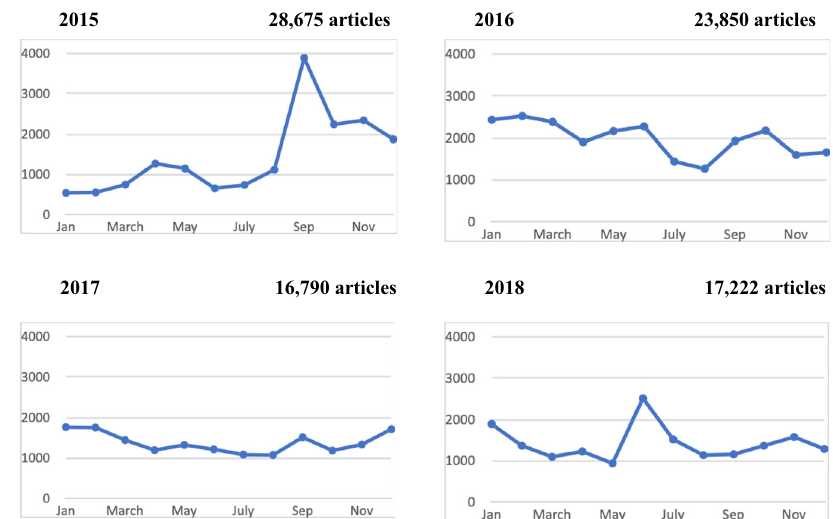
Fig. 1 British media coverage of migration. Monthly mentions of all keywords in 86,537 articles published between 2015 and